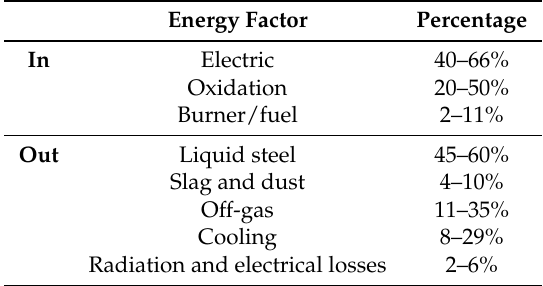
Table 1. The following percentages of energy sinks and energy sources are computed from a synthesis of reported values